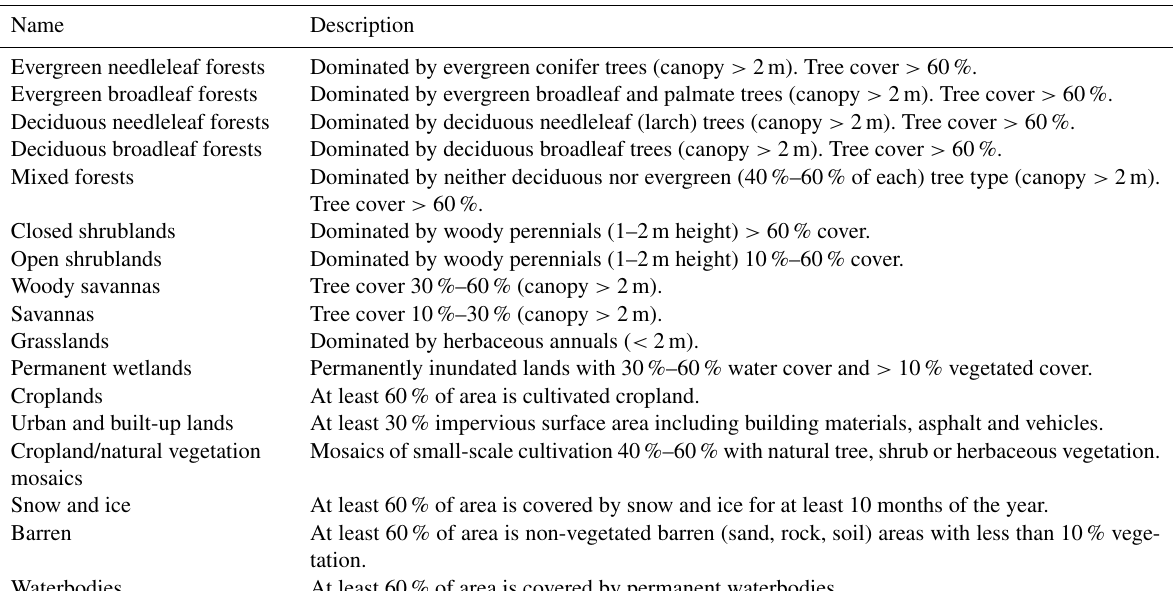
Table A1. IGBP land cover definitions, extracted and reprinted from Sulla-Menashe and Friedl (2018).